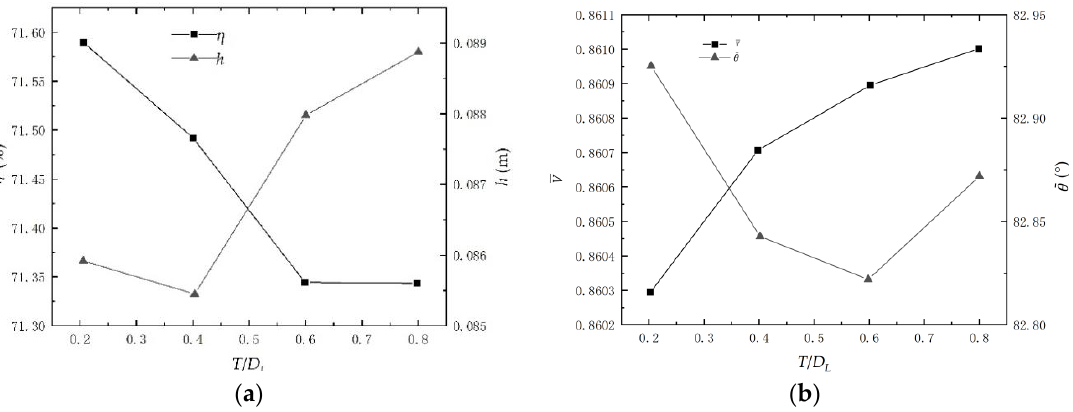
Figure 17. Hydraulic characteristics with different back wall distance. ( a ) Pump efficiency and hydraulic loss and ( b ) velocity uniformity and weighted average angle of exit velocity.